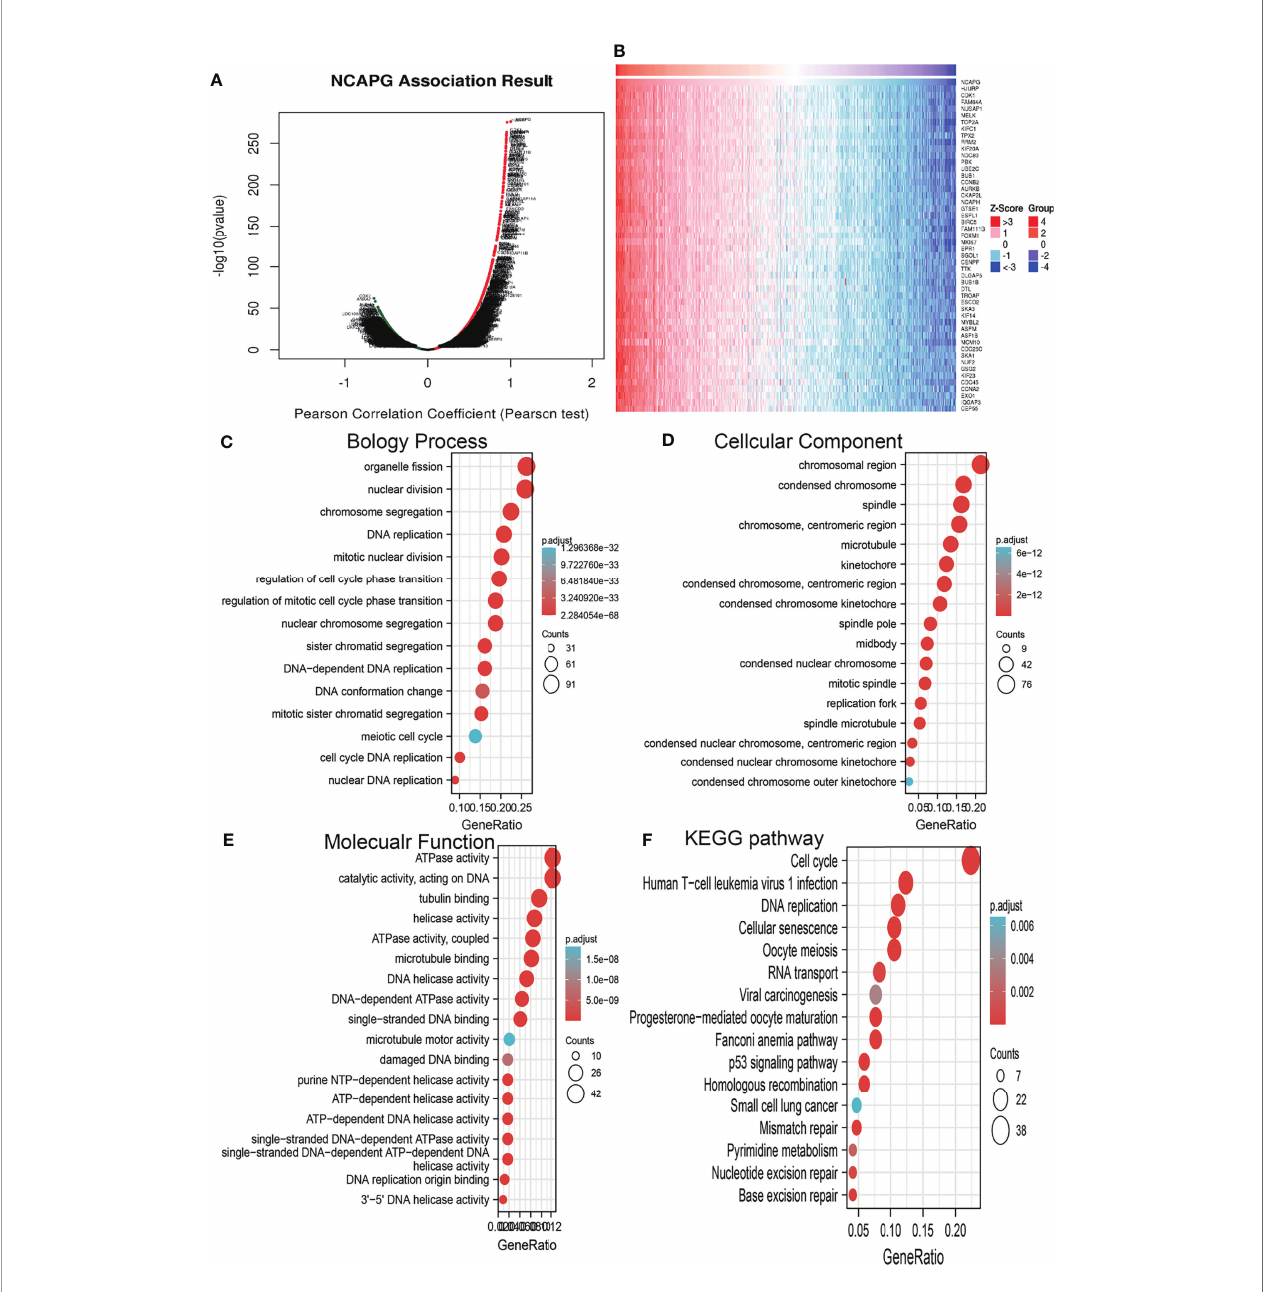
FIGURE 5 | Analysis of the biological function of NCAPG in glioma. (A, B) The co-expression gene of NCAPG in glioma explore by Linkedomics. (C – F) The GO and KEGG analysis of genes co-expressed with NCAPG in